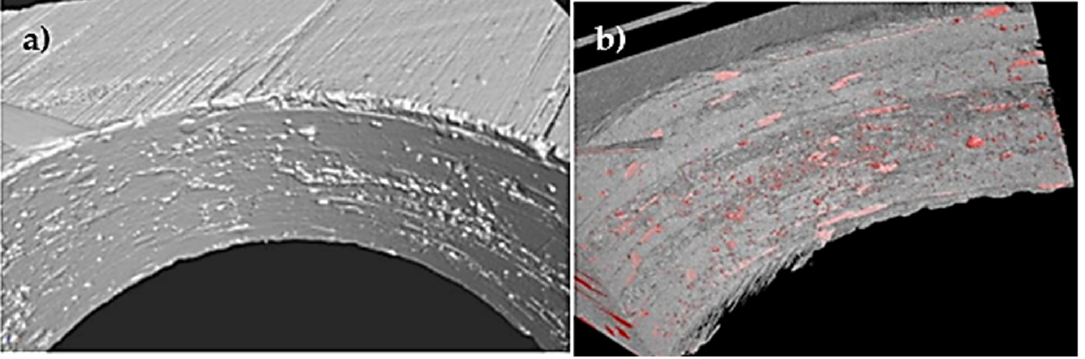
Figure 8. ( a ) A 3D model reconstructed from CT scan of the drilled hole, outer surface. The hole has a nominal diameter of 9.5 mm and ( b ) CT image of the inner wall of a 9.5 mm diameter hole, with glass fiber material highlighted in red [79].